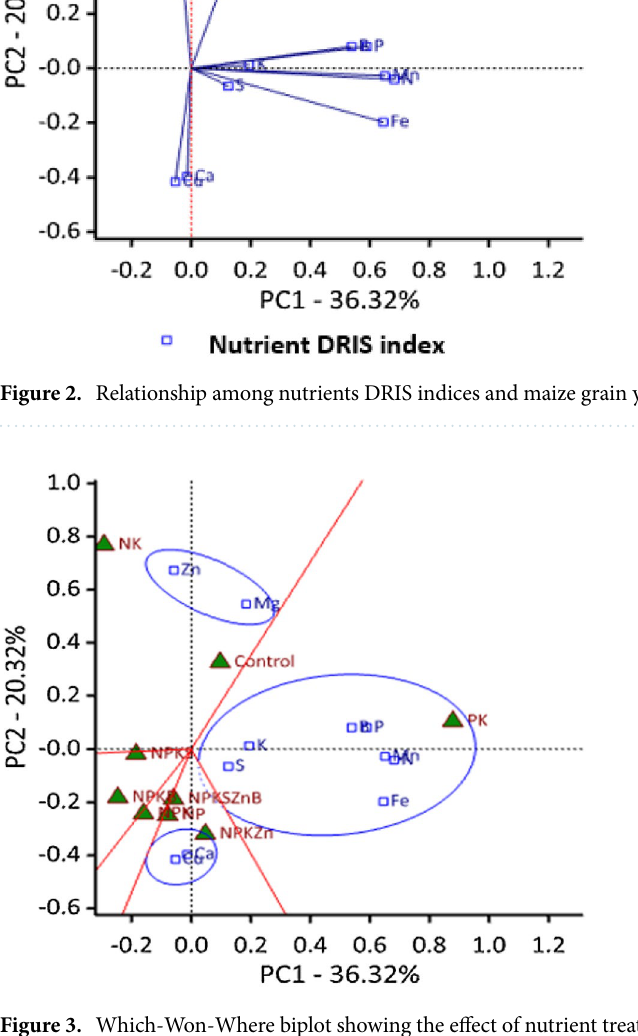
Figure 3. Which-Won-Where biplot showing the effect of nutrient treatments on DRIS indices and